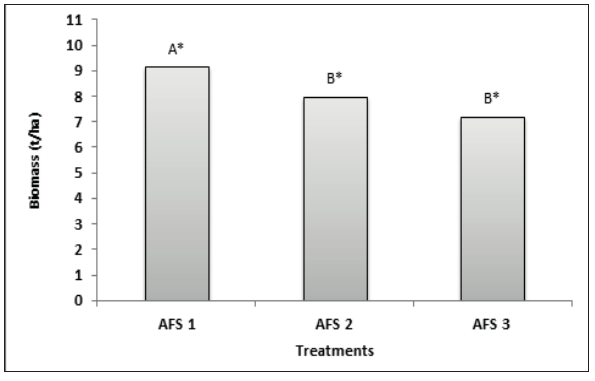
Figure 6. Biomass production of Centrosema covers for each of the agroforestry systems established in Santo Tomas